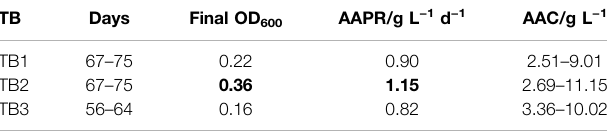
TABLE 4 | Calculated AAPRs over bio fi lm investigation of TB1, TB2 and TB3 with corresponding